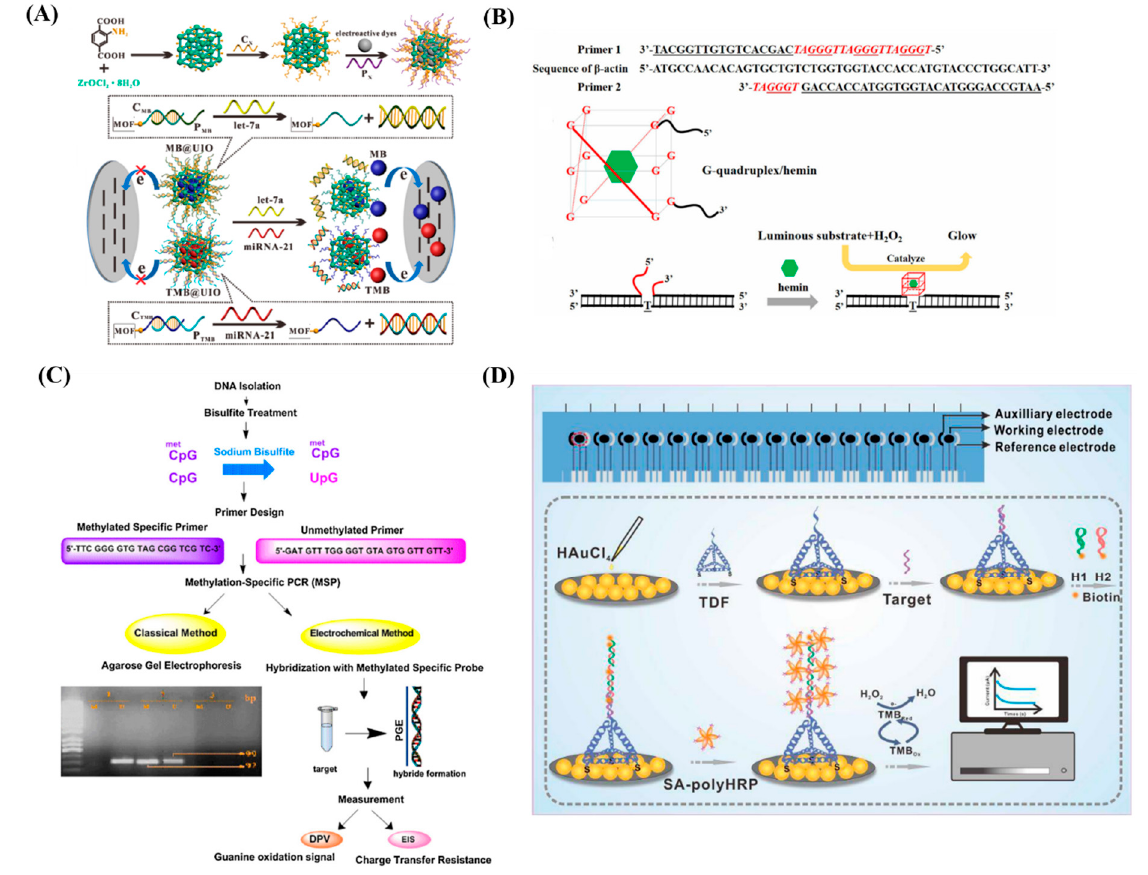
Figure 4. ( A ) Schematic representing the design and working principle of the MOF based biosensor. Re-used with permission from Ref. [39] ( B ) Overall mechanism of DNA G-quadruplex/hemin enzyme. Re-used with permission from Ref. [42] (Copyright, 2021 Elsevier, reproduced with permission from Elsevier Ltd.). ( C ) Schematic represents the detection of GSTP1 hypermethylation by electrochemical and electrophoretic methods. Re-used with permission from Ref. [45]. (Copyright, 2012 Elsevier, reproduced with permission from Elsevier Ltd.) and ( D ) Schematic representation of the E-cfDNA sensor Re-used with permission from Ref. [46].